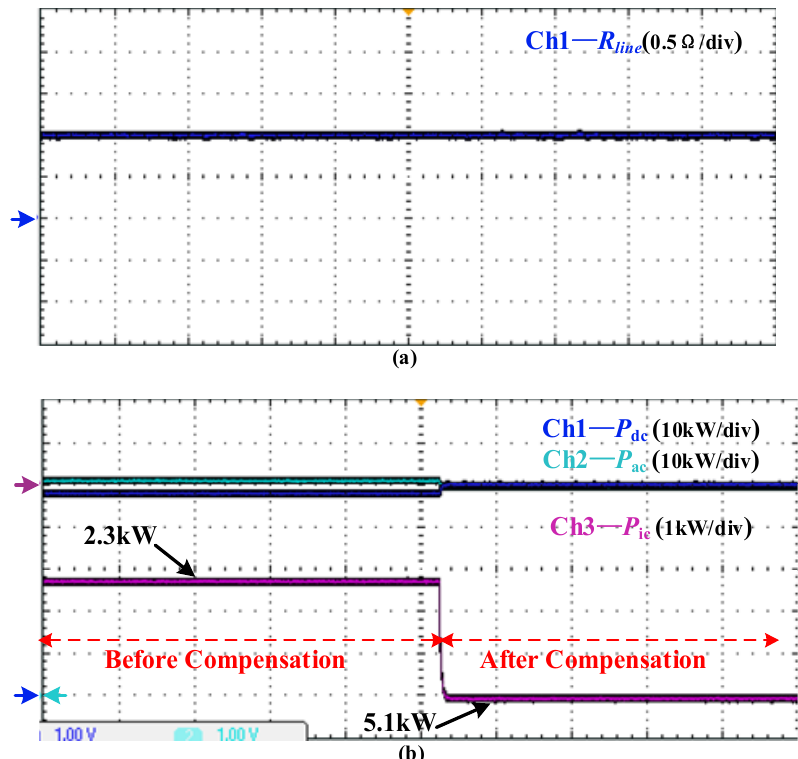
Figure 10. Experimental results when R line = 1, X line = 0.125 Ω ( x -axis: time, 1 s/div; y -axis: magnitude of the measured signal): ( a ) estimated impedance; ( b ) output power of sub-grids and IC.